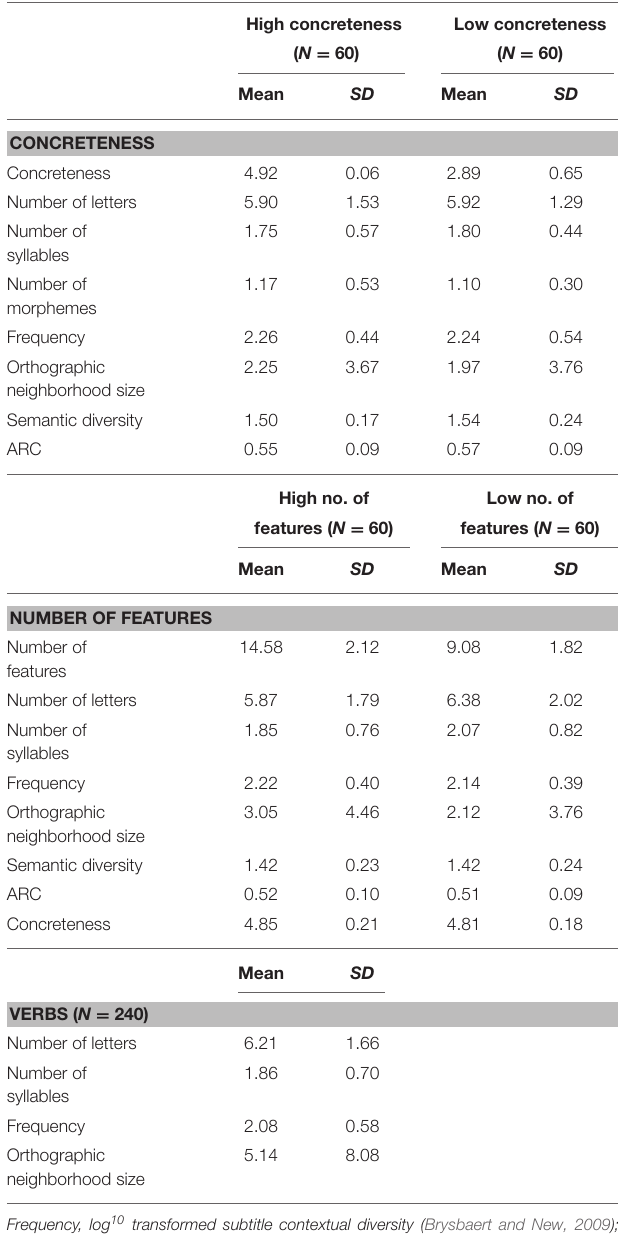
TABLE 1 | Descriptive statistics for the noun and verb stimuli used in Experiment